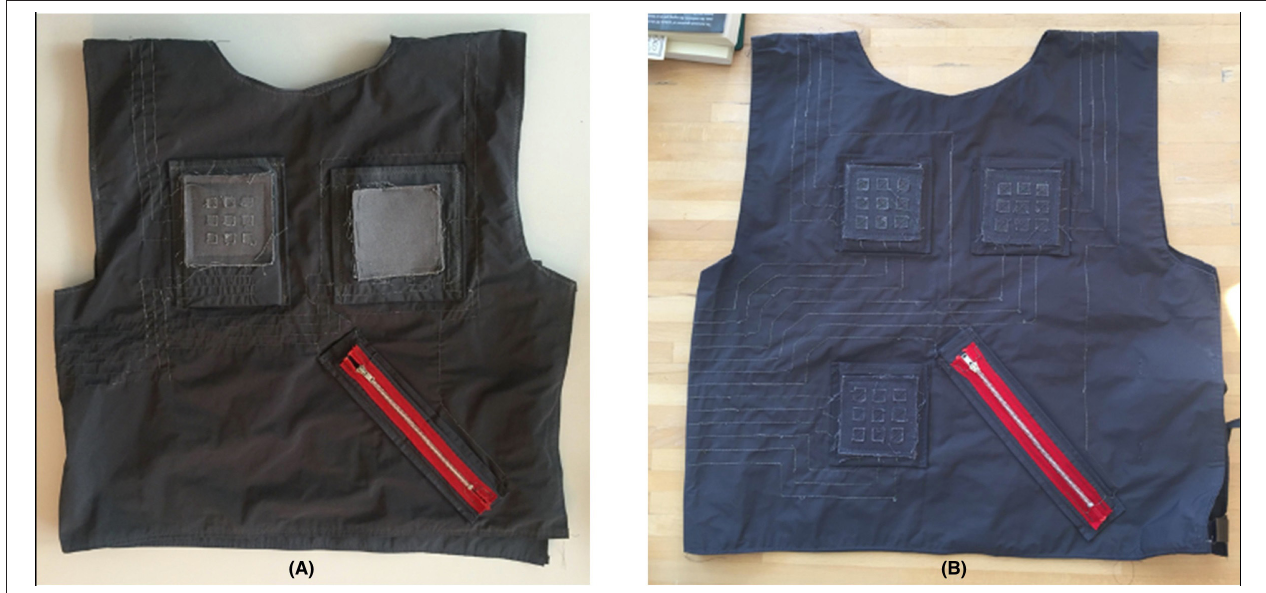
FIGURE 7 | (A) Second version of TIZI; (B) Third version of